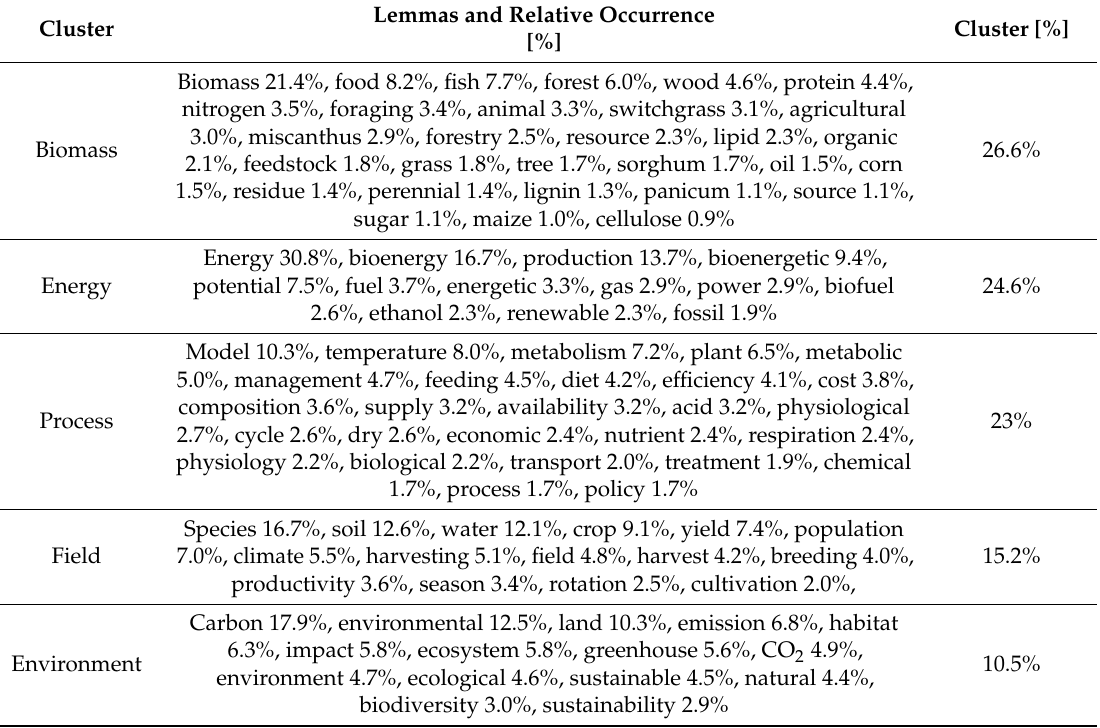
Table 5. Main clusters: clusters reported by highest frequency terms.